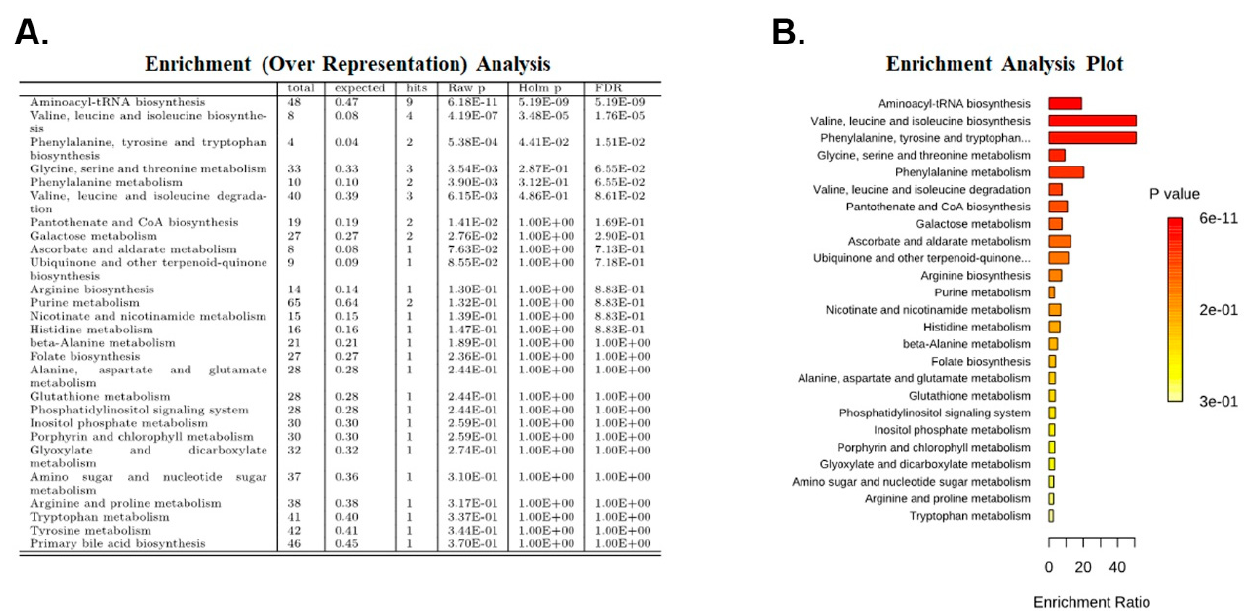
Figure 3. Enrichment analysis. Subjecting the 15 significantly altered metabolites to enrichment (over-representation) analysis identified 3 metabolic pathways with Holm p and FDR values < 0.05. Enriched pathways are shown in brackets. ( A ) Enrichment analysis table and ( B ) enrichment analysis graph.